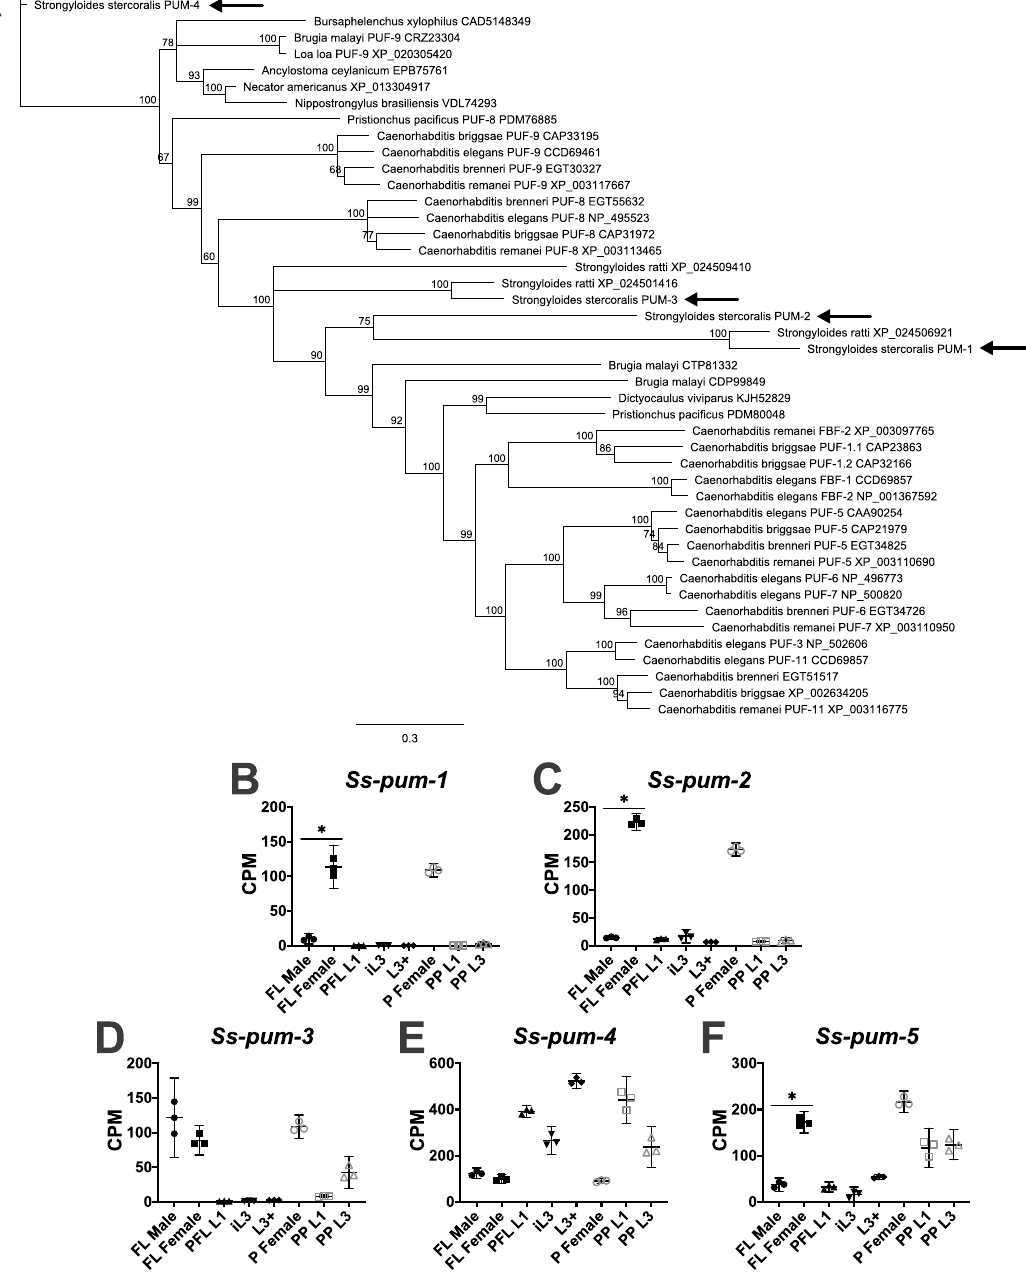
Figure 5. Genes encoding pumilio family proteins appear to have been duplicated in Strongyloides species. ( A ) Homologs of pumilio family proteins in S. stercoralis (arrows) and other clade III, IV, and V nematodes are identified in a neighbor-joining phylogenetic tree with 100 iterations of bootstrapping constructed with Geneious v.11.1.5. The genes encoding Ss -PUM-1, Ss -PUM-2, and Ss -PUM-3 appear to have resulted from a duplication in an ancestor of Strongyloides species. Gene names and accession numbers are listed after the species names. ( B - F ) Transcript abundances of the S. stercoralis homologs are represented using TMM- normalized counts per million (CPM) for the following developmental stages: free-living adult males (FL Male), free-living gravid adult females (FL Female), post-free-living first-stage larvae (PFL L1), developmentally arrested infectious third-stage larvae (iL3), L3 activated inside a permissive host (L3 +), parasitic gravid adult females (P Female), heterogonically-developing post-parasitic L1 (PP L1), and heterogonically-developing post- parasitic L3 enriched for females (PP L3). Graphs were constructed using GraphPad Prism v.9.0.0; bars indicate means (horizontal) and 95% confidence intervals (vertical) for each of the three biological replicates represented as individual data points. Asterisks (*) indicate a significant (fold change > 2.0; FDR < 0.05) difference between FL Male and FL